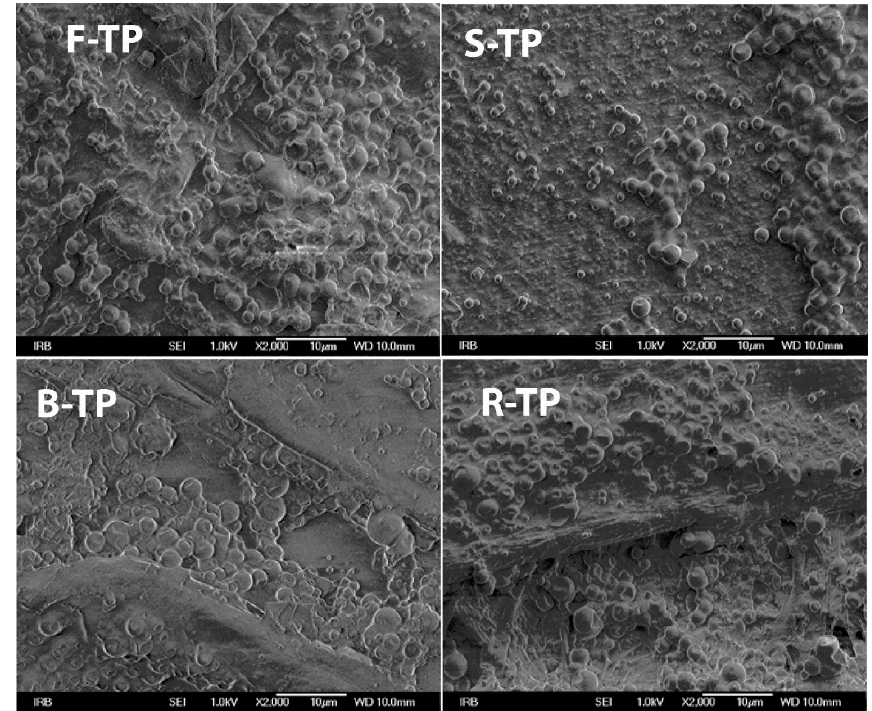
Figure 5. SEM micrographs of thermochromic prints (magnification 2000×).